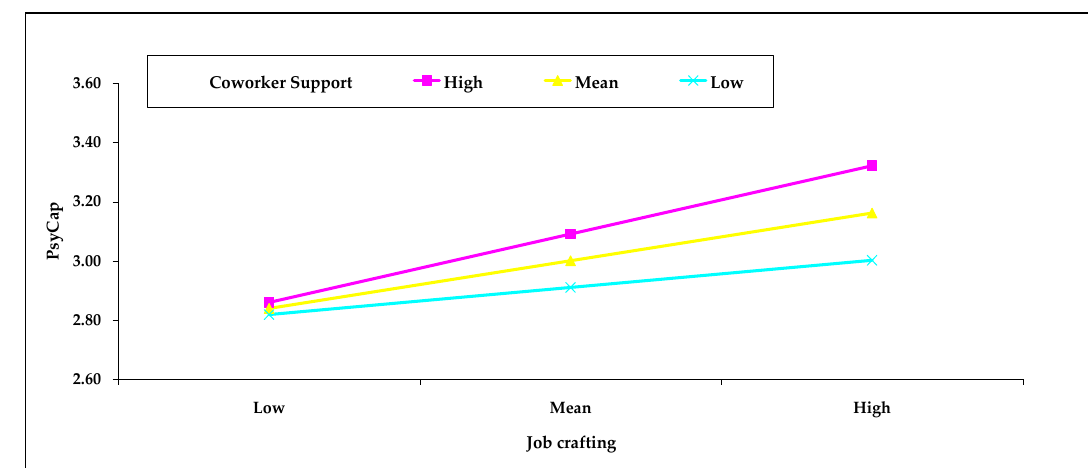
Table 5. Moderating effect of coworker support.